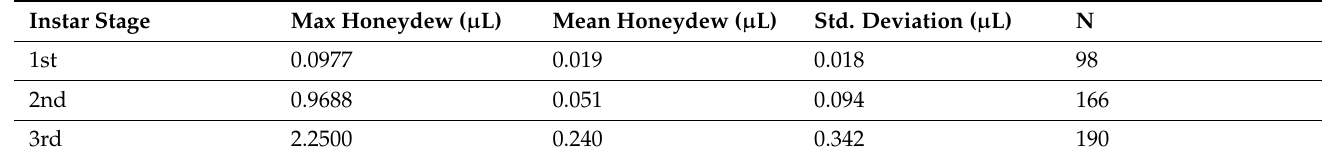
Table A4. Summary of Marchalina hellenica honeydew volume produced by instar stage. Sample sizes vary due to differences in honeydew production rates and temporal distribution.